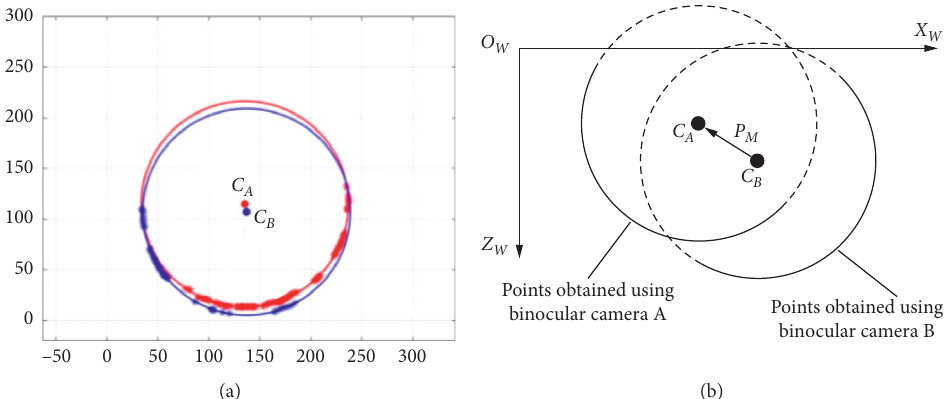
Figure 12: Stitching correction process: (a) calculating C A and C B by circle fitting; (b) calculating P M according to C A and C B .